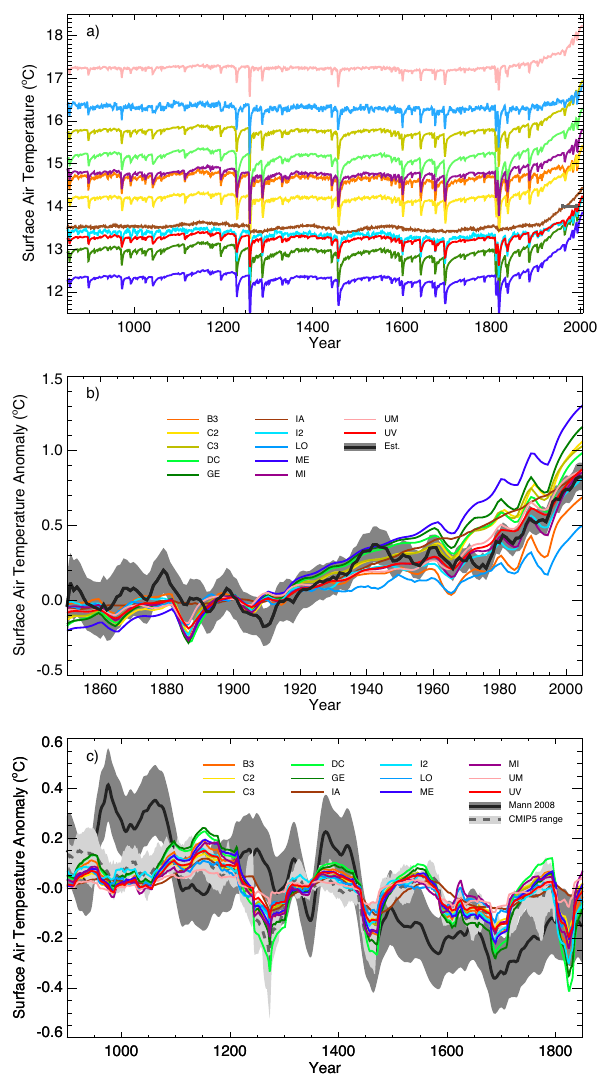
Fig. 2. Global surface air temperature from the historical all-forcing simulation for 12 of the participating models. Absolute tempera- tures are shown for the entire simulation in (a) . The small dark grey bar at 14 ◦ C between 1960 and 1990 is an estimate of the average absolute surface air temperature from Jones et al. (1999) over this period. Temperature anomalies from 1850 are shown in (b) . The dark grey line shows changes in SAT, and the grey shading indi- cates the uncertainty, from Morice et al. (2012). The model results and the data estimates are shown as anomalies from the average over the decade centred at year 1900 and have been processed with a 5yr moving average, rectangular filter. Temperature anomalies before 1850 are shown in (c) . The dark grey line shows changes in global SAT, and the grey shading indicates the uncertainty, from the error- in-variables (EIV) reconstruction of Mann et al. (2008). The grey dashed line shows the model mean, and the light grey shading the model range, of the CMIP5 models that carried out the PMIP3 “last millennium” experiment. The model results and the data estimates are shown as anomalies from the average over the entire period (900 to 1850 or 900 to 1800 for the CMIP5 models) and have been pro- cessed with a 30yr moving average, rectangular